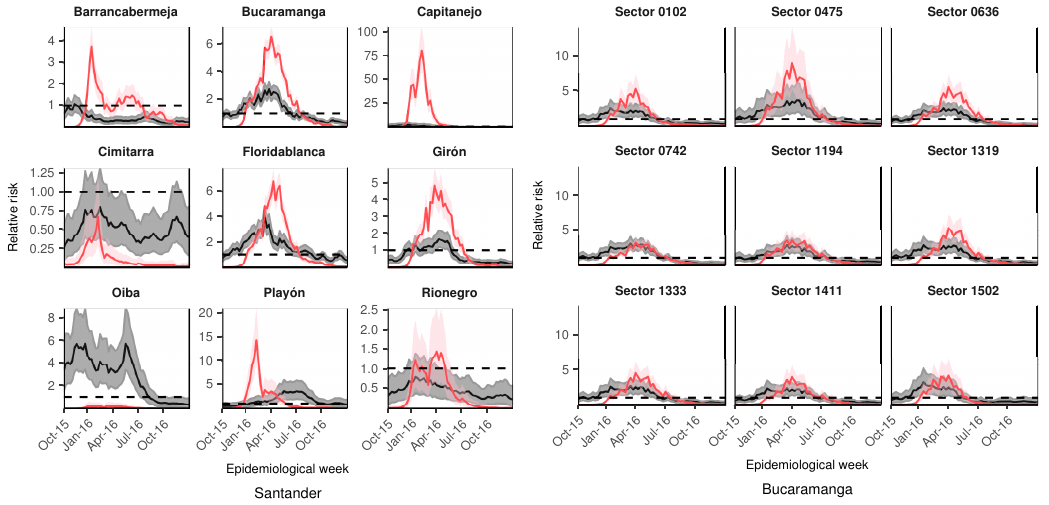
Figure 6. Selected longitudinal profiles of the posterior means and 95% credible intervals for the relative risk of dengue (gray shadow) and Zika virus disease (ZVD) (pink shadow) for department of Santander and city of Bucaramanga from October 2015 to December 2016. Dashed lines correspond to relative risk equal to